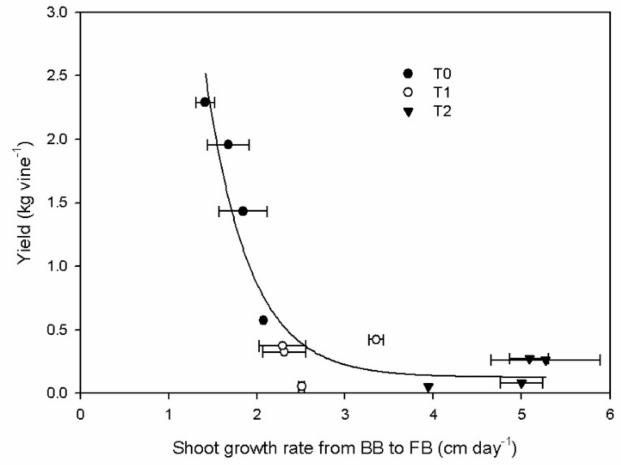
Vine yield was negatively correlated with shoot growth rates from budburst to full bloom (R 2 = 0.90, p < 0.0001) (Figure 8).